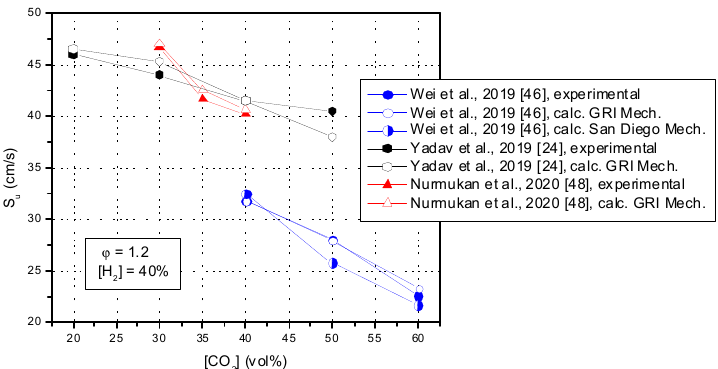
Figure 15. Influence of CO 2 concentration on the laminar burning velocities of biogas mixtures with equivalence ratio of 1.2 enriched with 40 vol% H 2 , at standard initial conditions.